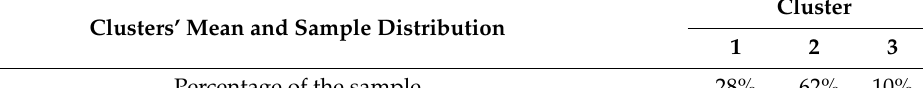
Table 5. Final cluster centers.